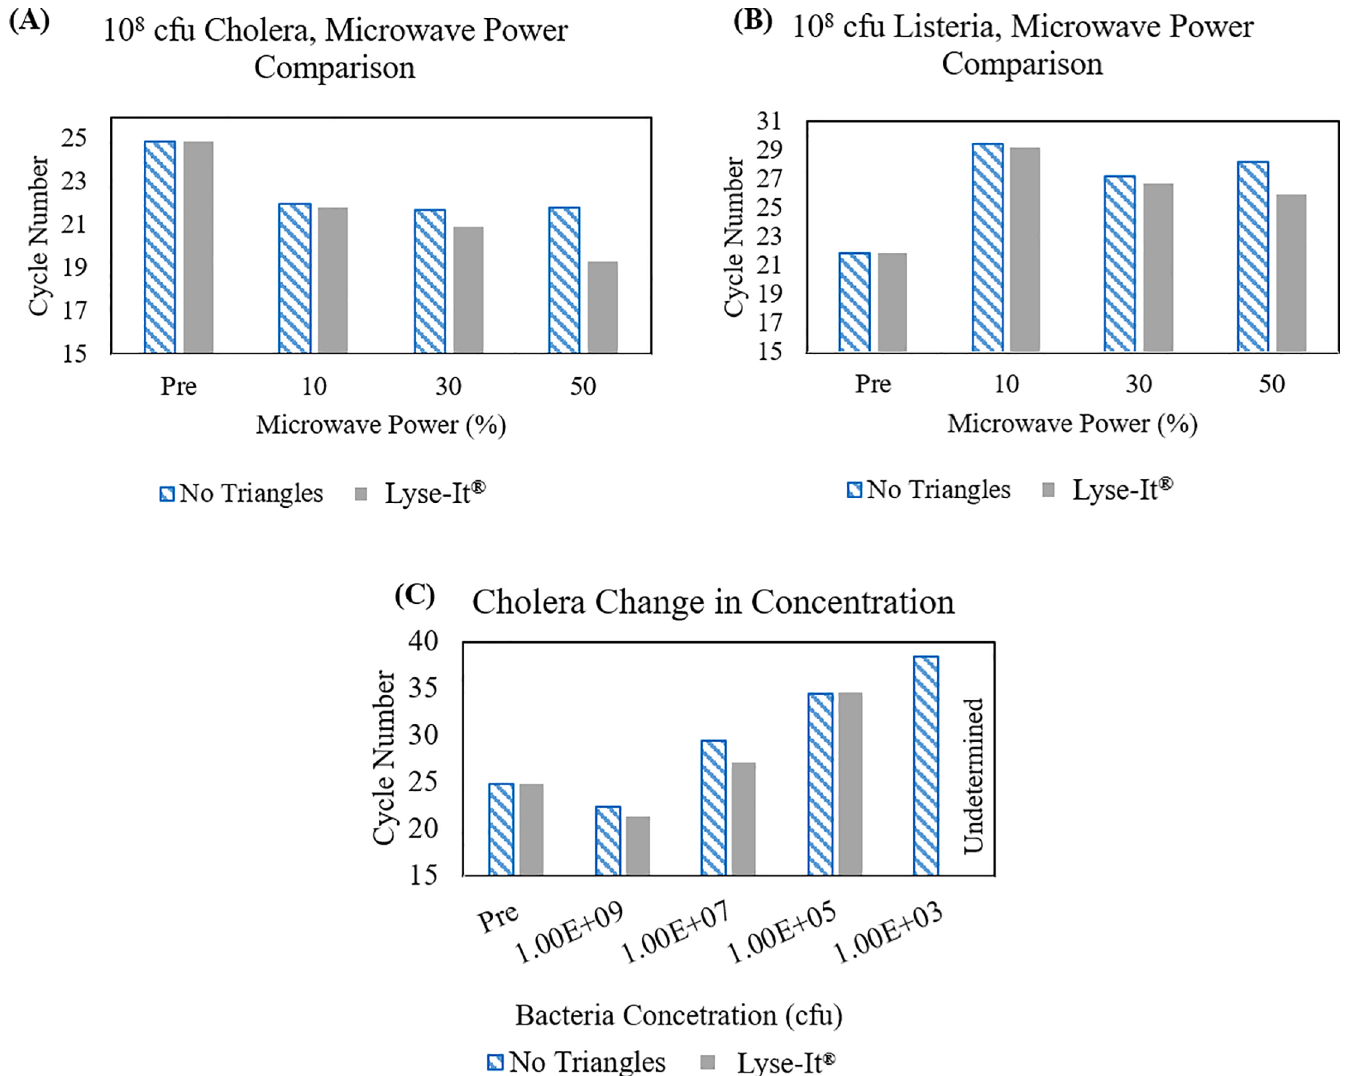
Fig 5. qPCR for the detection of V . cholerae . qPCR cycle number for increasing microwave irradiation powers and decreasing V . cholerae concentrations. (A/B) Decreasing cycle numbers with the use of triangles indicated an increase in released target DNA. (C) Increasing cycle numbers for decreasing concentrations of target